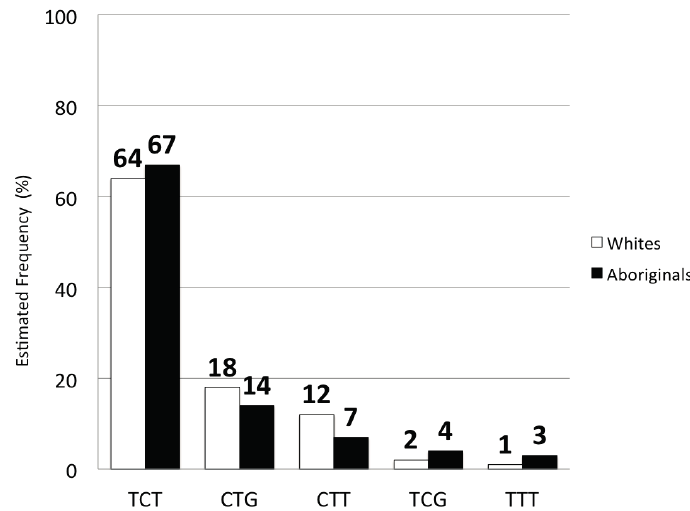
Figure 2. Haplotype distribution in Canadian-born Whites and Aboriginals. Haplotypes containing the favourable alleles at all three SNPs (TCT) are more common in Aboriginals than whites while the opposite is true about haplotypes with the disadvantageous alleles (CTG). TCT = T at rs8103142, C at rs12979860 and T at